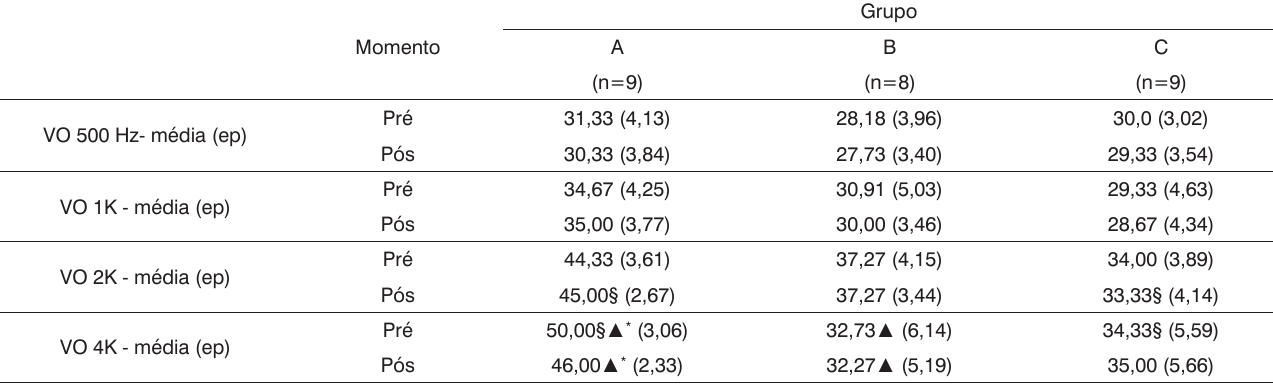
Tabela 1. Limiar auditivo na via óssea (VO) - médias e erros padrão (ep) ajustados para dependência entre as medidas do mesmo